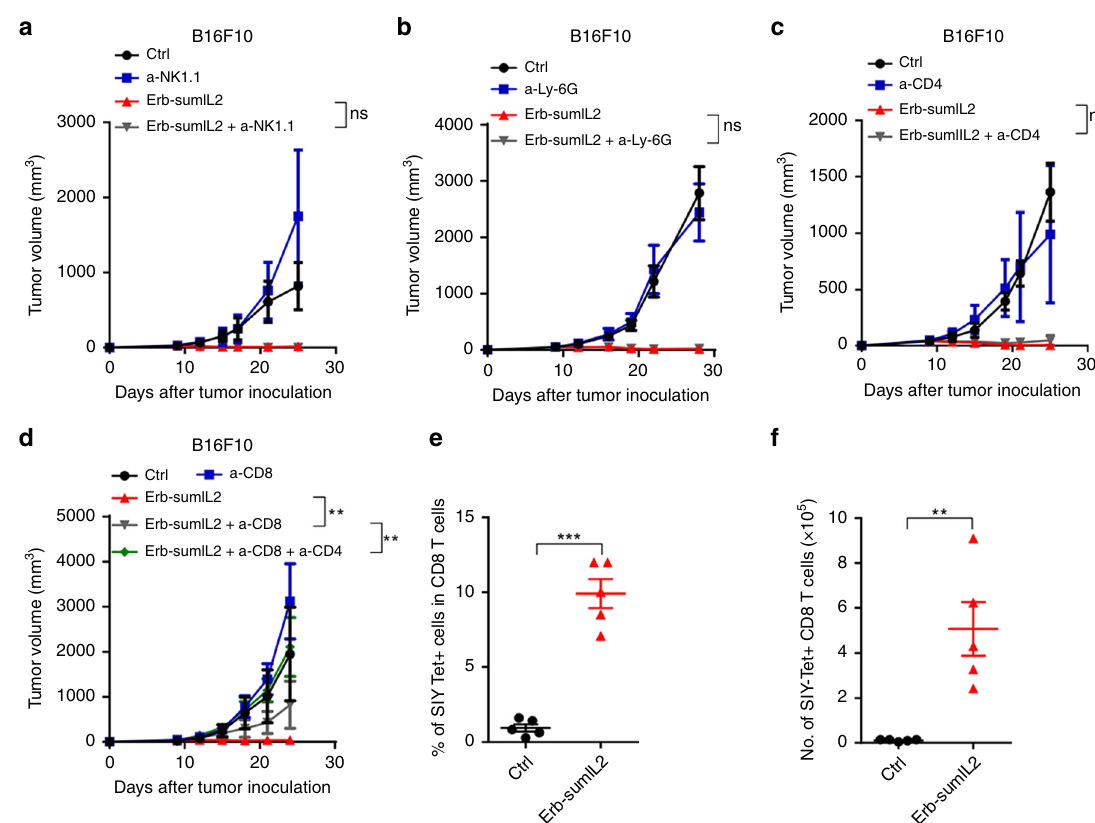
Fig. 3 CD8 + T cells are essential for Ab-sumIL2 therapy. a – d WT C57BL/6 mice ( n = 5/group) were injected subcutaneously with 5 × 10 5 B16F10 cells, and i.t. treated with 10 μ g of Erb-sumIL2 on days 9, 12, and 15. Anti-NK1.1 ( a ) and anti-Ly-6G ( b ) were injected at a dose of 400 μ g per antibody, 8 days after tumor inoculation and every 4 days thereafter for 3 times. Anti-CD4 ( c ) and anti-CD8 ( d ) were injected at a dose of 200 μ g on the same day as Erb- sumIL2. e , f WT C57BL/6 mice ( n = 5/group) were injected subcutaneously with 7.5 × 10 5 B16-SIY cells and i.t. treated with 10 μ g of Erb-sumIL2 on day 9. The tumor tissues were collected on day 15. Antigen-speci fi c CD8 T cells in the tumor site were detected using SIY tetramer. The frequency of SIY-speci fi c CD8 T cells among total CD8 T cells ( e ) and the number of SIY-speci fi c CD8 T cells ( f ) were analyzed by fl ow cytometry. Two way ANOVA tests were used to analyze the tumor growth data. Unpaired T-tests were used to analyze the other data. ns (not signi fi cant), * P < 0.05, ** P < 0.01, *** P < 0.001, and **** P < 0.0001. One of the two or three representative experiments is